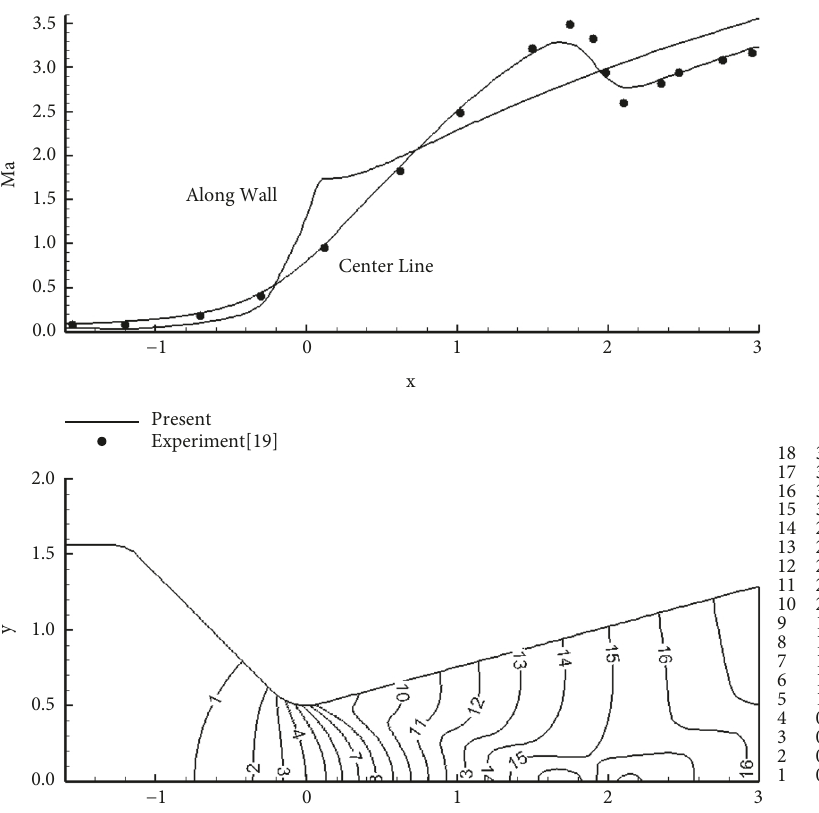
Figure 2: One-phase flow field and Mach number